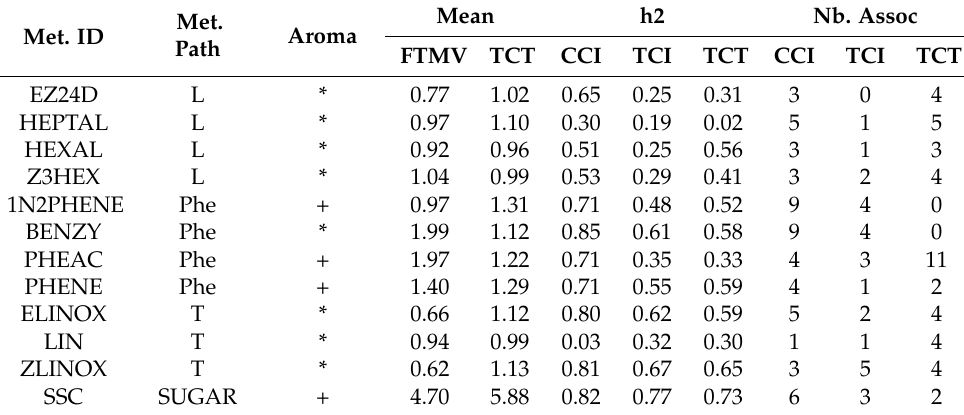
Table 2. Cont. Met.